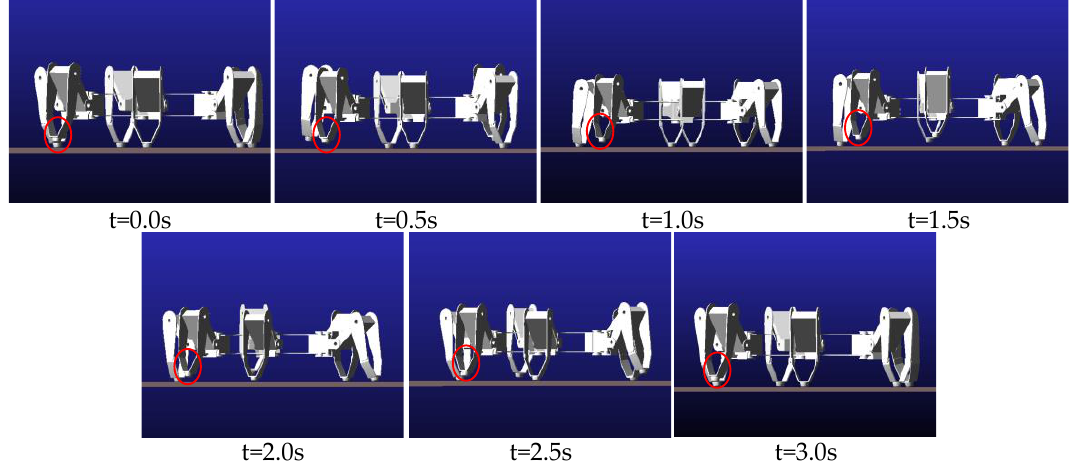
Figure 15. Lateral view of one period simulation sequence with leg 1 fault.